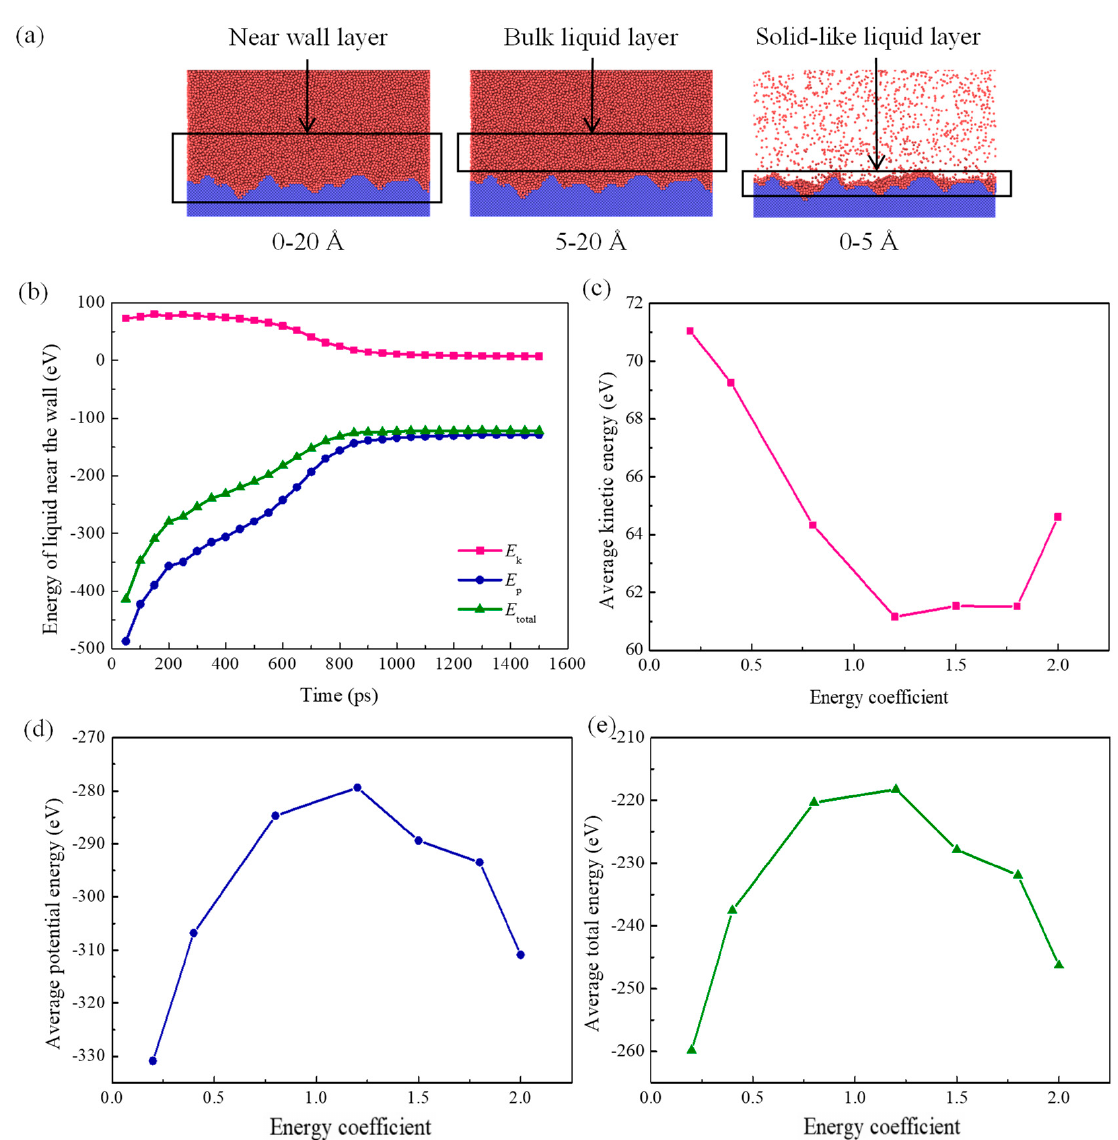
Figure 10. ( a ) The schematic of the liquid configuration in the near-wall region (from z = 0 Å to z = 20 Å), the bulk liquid layer (from z = 5 Å to z = 20 Å), and the solid-like liquid layer (from z = 0 Å to z = 5 Å); ( b ) The time evolution of different energies in the near-wall layer when α = 1.5; The average kinetic energy ( c ), average potential energy ( d ), and average total energy ( e ) with different solid–liquid interactions.